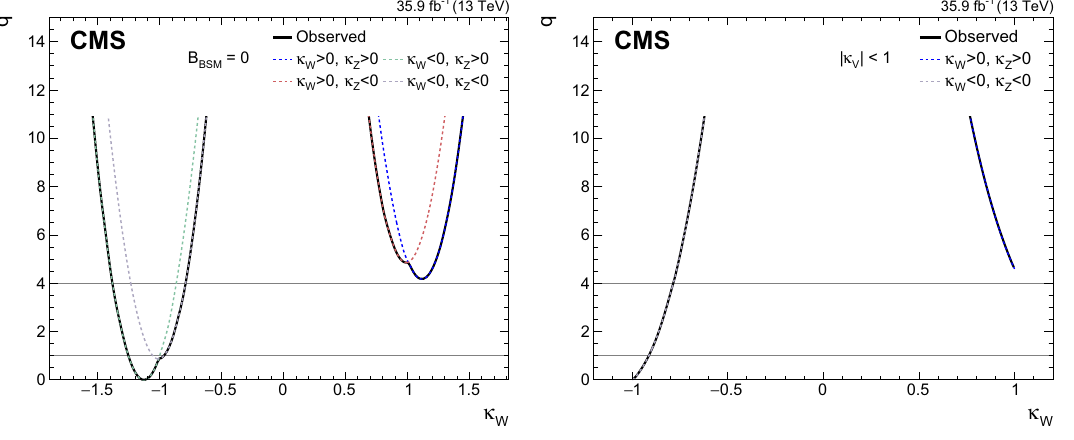
Fig. 13 Scan of the test statistic q as a function of κ W in the generic κ model assuming B BSM = 0 (left) and allowing B inv and B undet to float (right). The different colored lines indicate the value of q for different combinations of signs for κ W and κ Z . The solid black line shows the